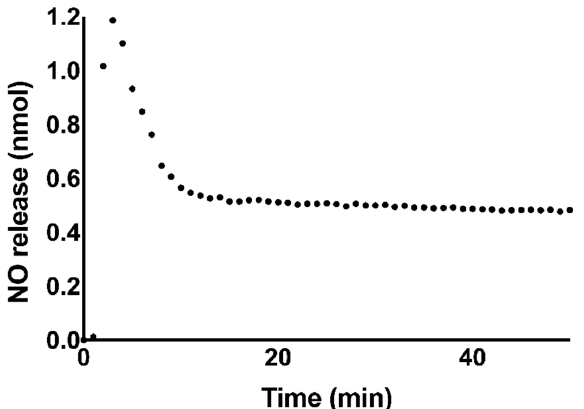
Figure 7. Representative graph of NO-release from 1 mM GSNO in PBS measured using a Nitric Oxide